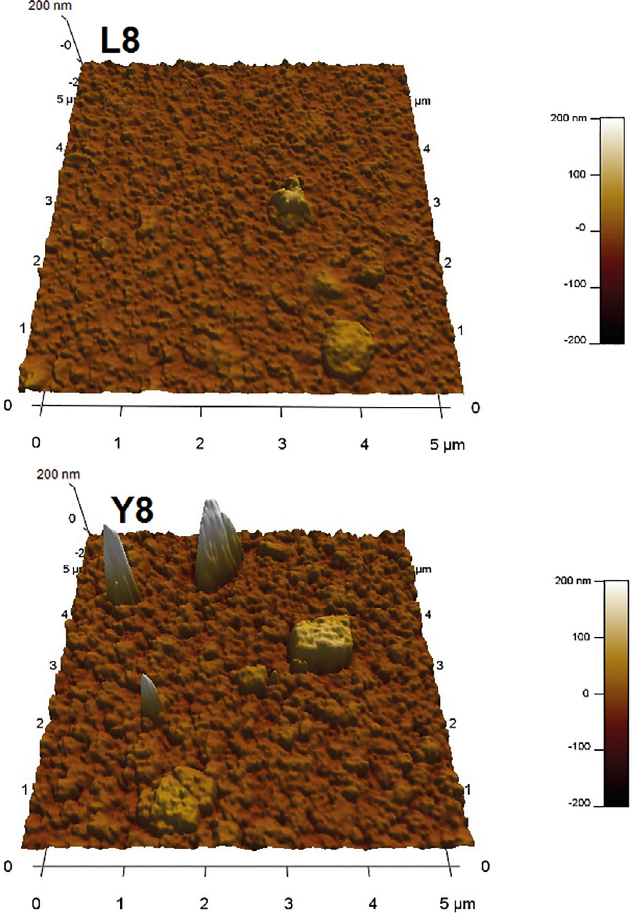
Figure 4. 3D topography obtained by AFM for 5μm x 5μm regions of the LCMO (L8) and YBCO (Y8) top layers for the superlattices having 8nm layer of